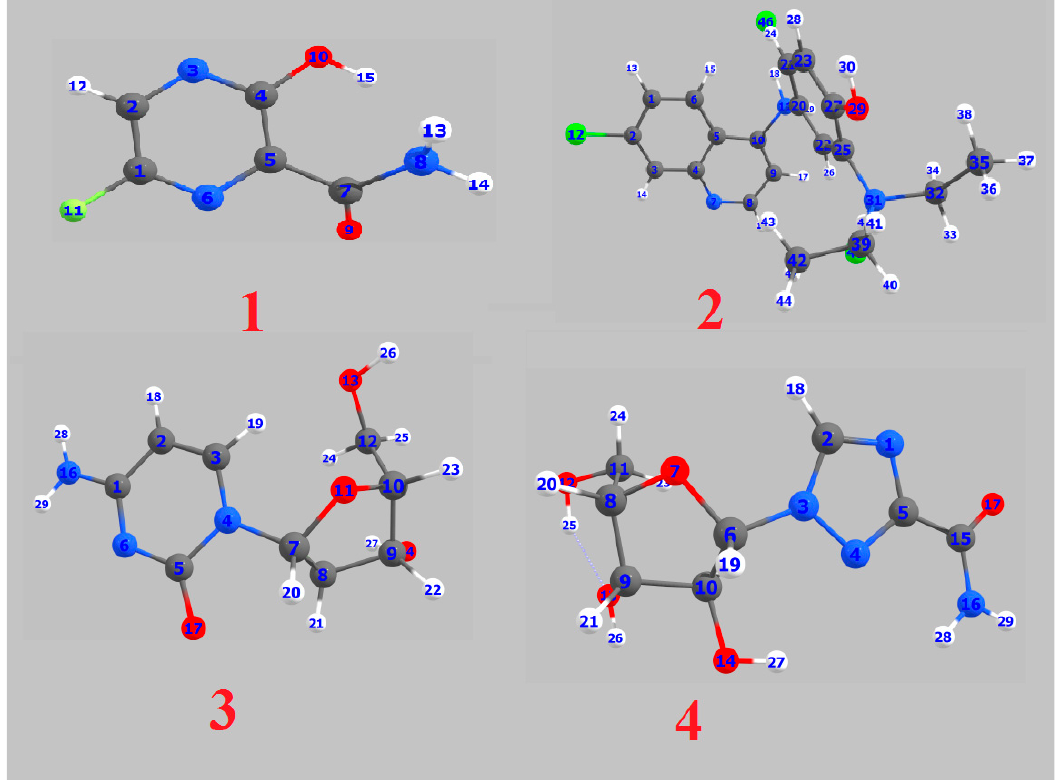
Figure 1. Optimized geometrical structures of present compounds 1 ‒ 4 with atomic numbering. Table 1. Thermal parameters (Hartree / Particle), polarizability α (Bohr 3 ), and dipole moment (Debye) of 1–4 .